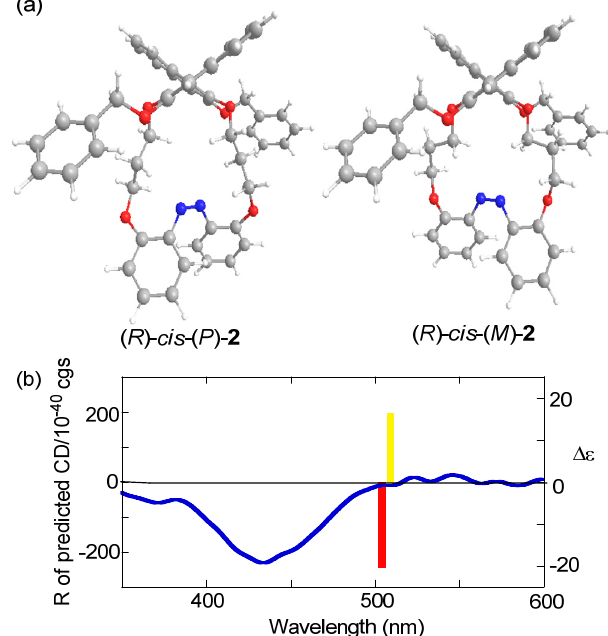
Figure 11. (a) Optimized structures of ( R )- cis -( P )- 2 and ( R )- cis -( M )- 2 obtained by the symmetry. (b) CD calculated by DFT calculations at the B3LYP/6-31G(d) level under C 2 the TD-DFT method with the B3LYP/6-31G(d) level of ( R )- cis -( P )- 2 (red bar), ( R )- cis - ( M )- 2 (yellow bar), and experimental CD of ( R )- 2 after 365-nm irradiation (blue line, 1 × 10 − 5 M in 1,4-dioxane, 20 ° C).